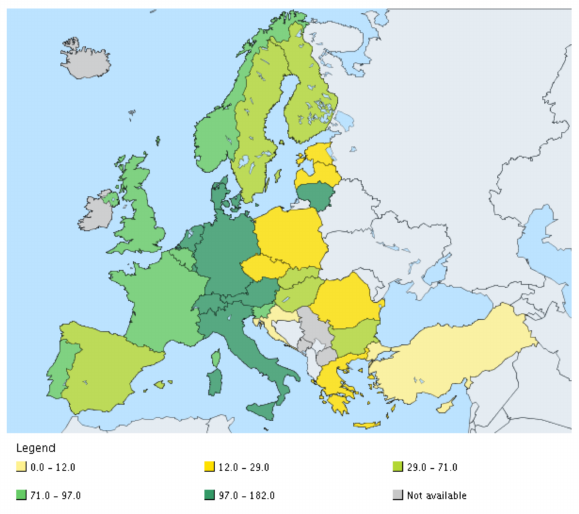
Figure 2. Recycling of biowaste (kg per capita) in di ff erent countries in 2017 provided by Eurostat